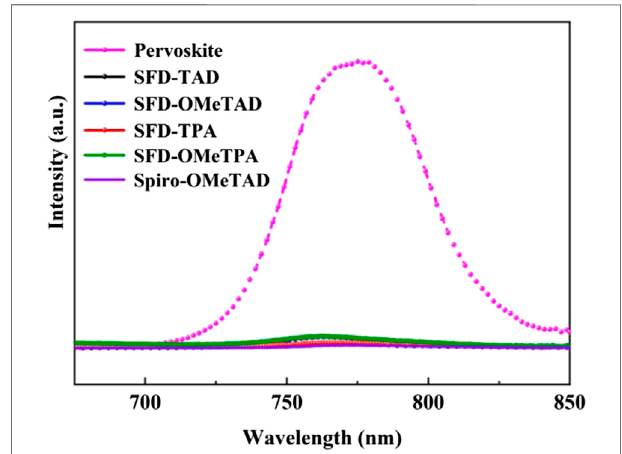
Frontiers in Chemistry |